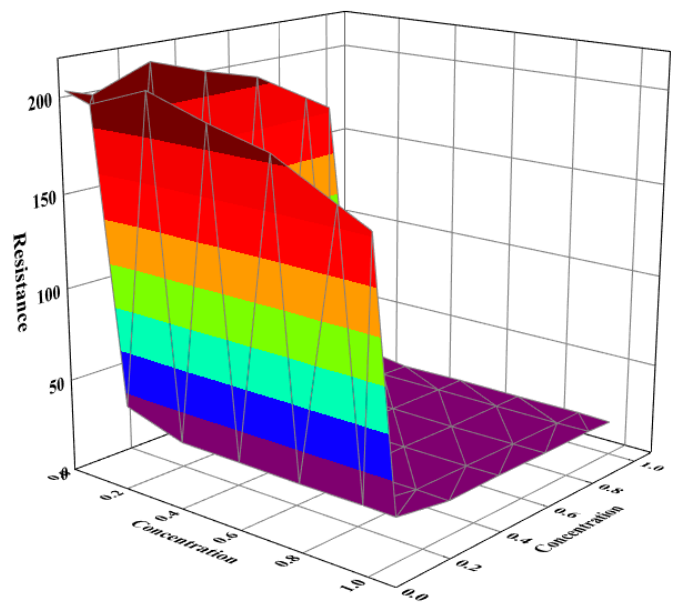
Figure 9. Membrane resistance of different concentrations on either side of the membrane. Table 3. The membrane impedance R s+m ( Ω cm 2 ) at electrolytes C1 and C2 (M) on both sides of the membrane, as measured by DC chronopotentiometry.